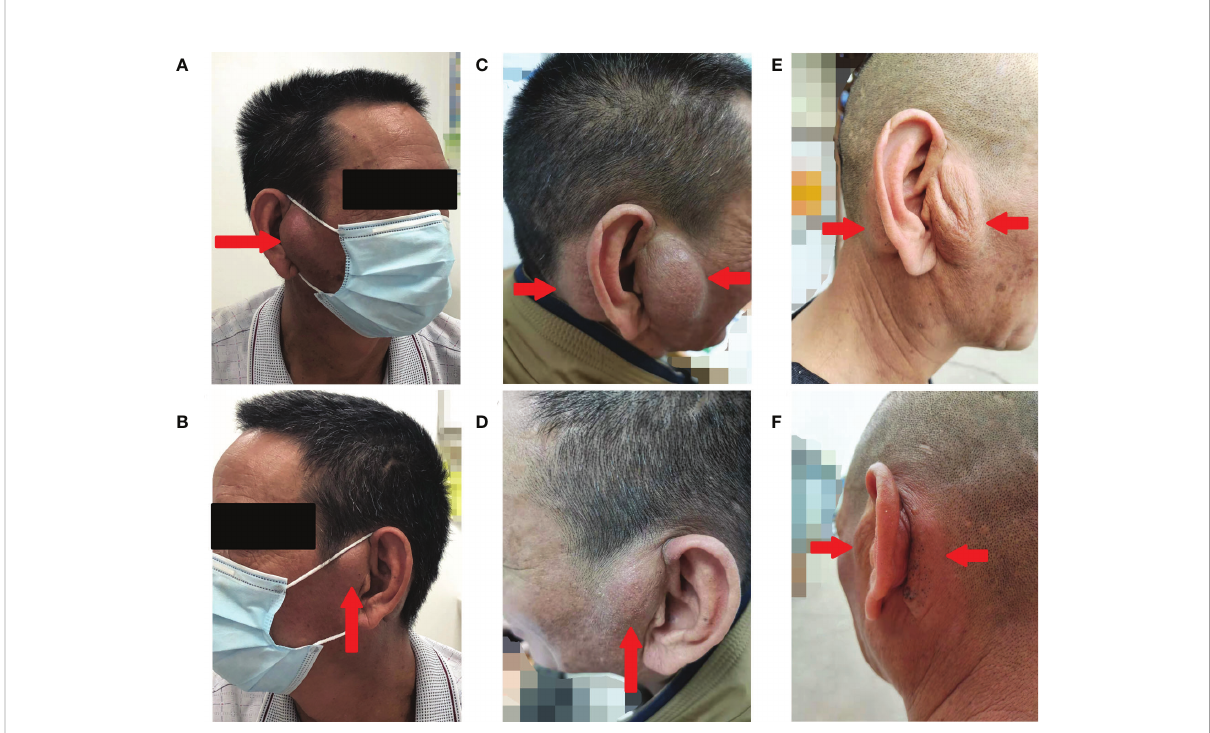
FIGURE 1 Photographs of the bilateral anterior and posterior ears of the patient. Before the treatment (A, B) , after 19 months of treatment with omalizumab (C, D) , and after 16 weeks of treatment with dupilumab (E, F) (arrows indicate tumorous